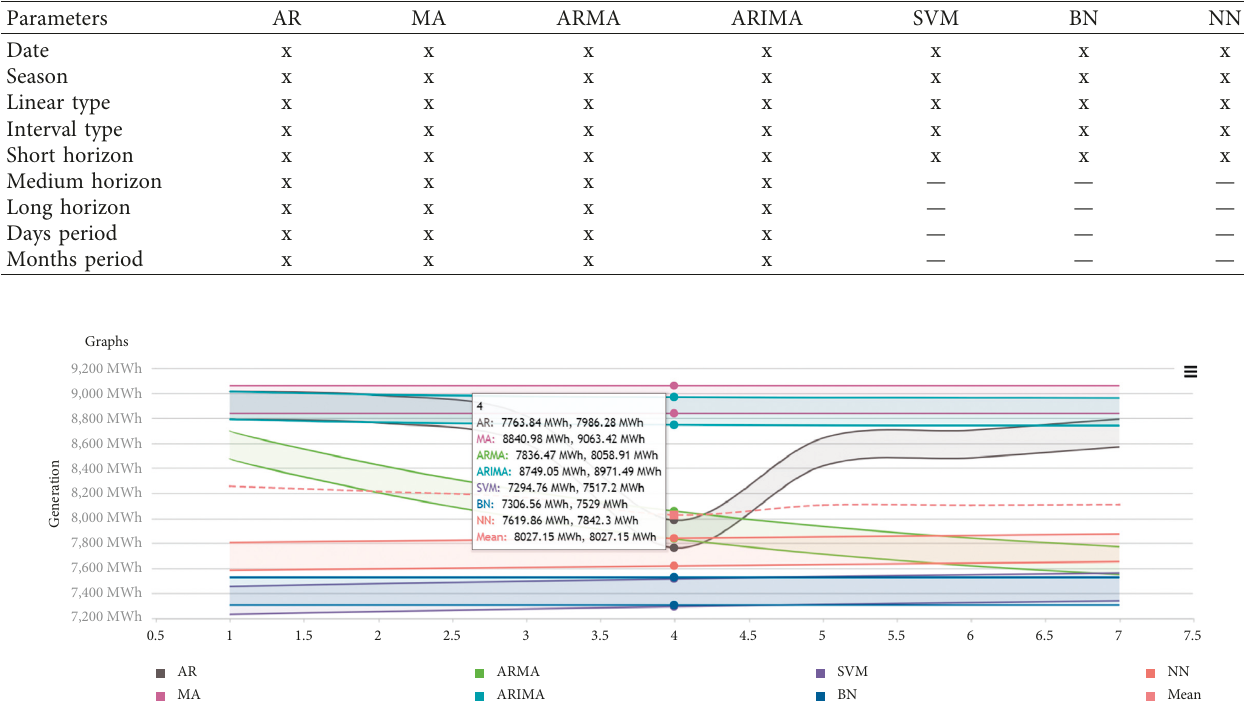
Table 4: Selectable parameters for each